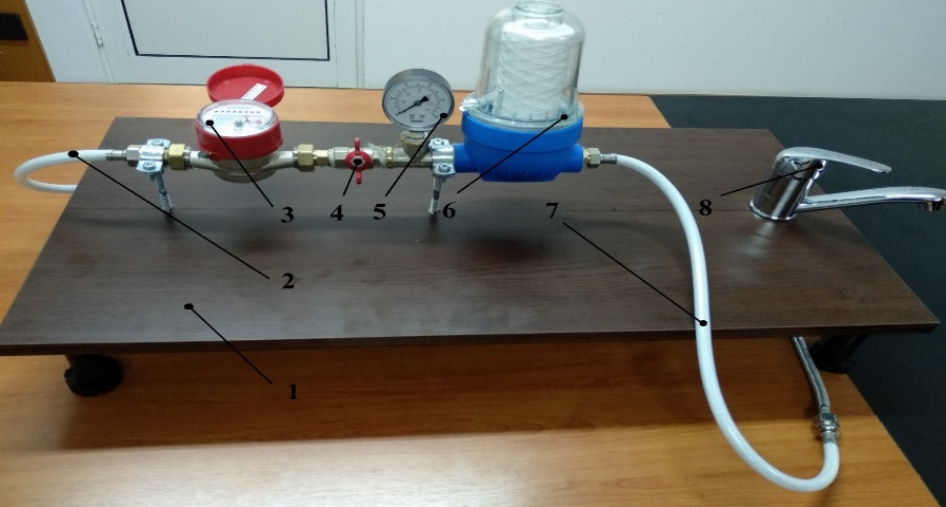
Figure 2. Experimental stand for testing the drinking water filters.